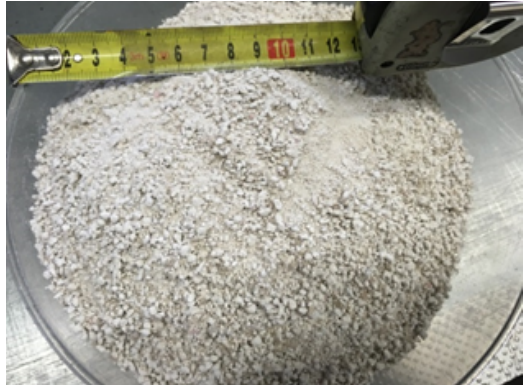
Figure 4. Milled gypsum before sorting and without